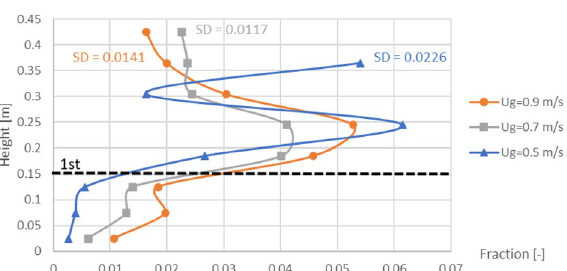
Figure 13. Effect of gas inlet velocity on time-and-area-averaged biomass fraction in case of the baffled gasifier with biomass feeding at